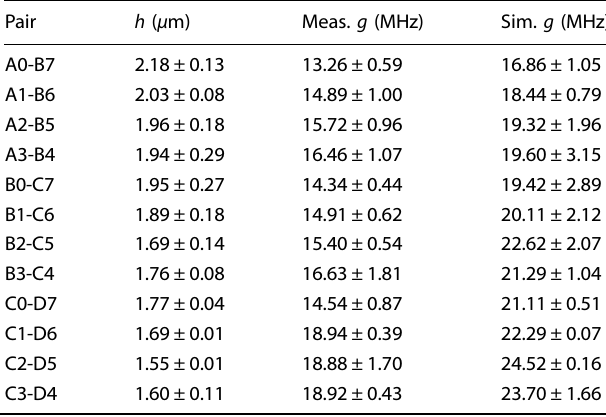
Table 1. Bare coupling rate, g , as measured from the qubit-qubit dispersive shift, χ qq compared to simulated values given measured bump heights, h .